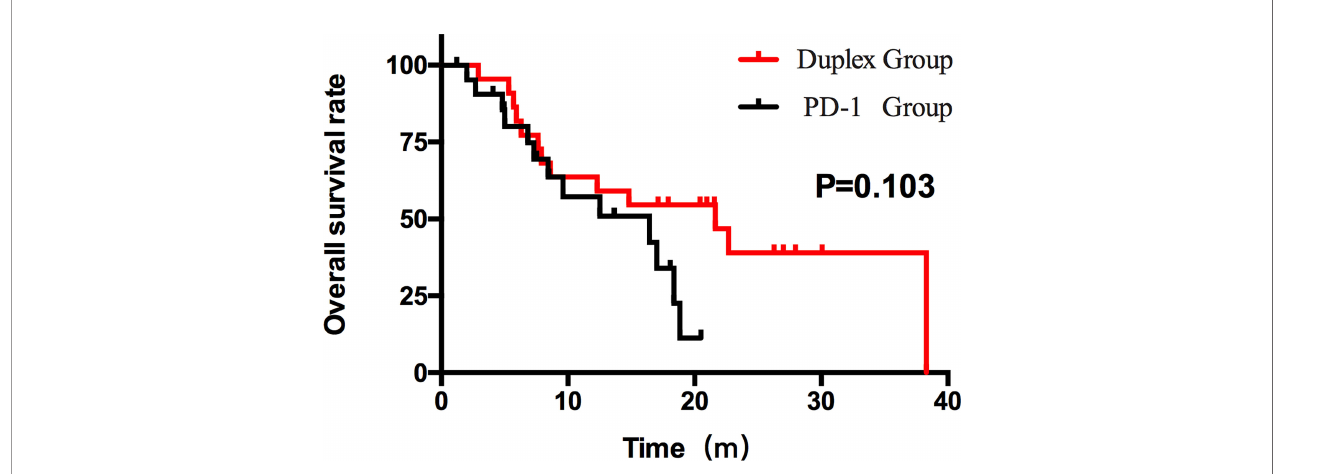
FIGURE 4 | OS of the duplex group and the PD-1 group. The OS results between the two groups were different (21.63 months and 16.43 months). However, the difference was not statistically signi fi cant ( p >